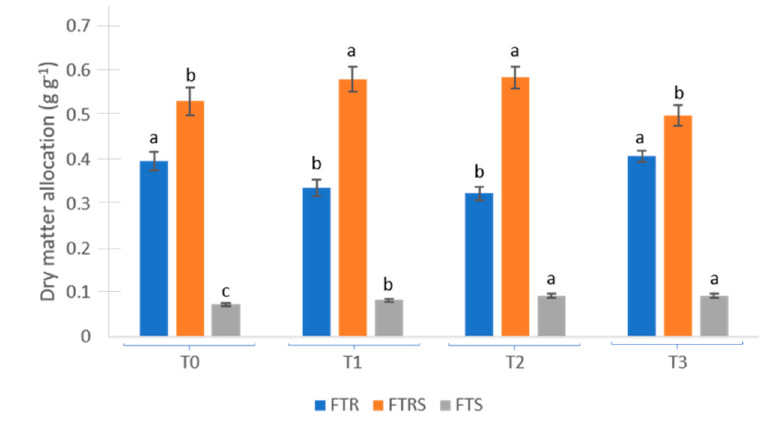
Figure 1. Dry matter allocation to different part of the bare-rooted vines in the compared thesis. T0 = unfertilized pot; T1 = fertilized pot with commercial NPK fertilizer (Osmocote Topdress); T2 = fertilized pot with LWA based on spent coffee ground, glass and N fertilizers; T3 = fertilized pot with LWA based on spent coffee grounds + biochar, glass and N fertilizers; FTS = fraction of total dry weight allocated to shoot; FTRS = fraction of total dry weight allocated to above-ground rootstock); FTR = fraction of total dry weight allocated to root Bars indicate standard deviations. Means followed by the same letter do not significantly differ at p ≤ 0.05.